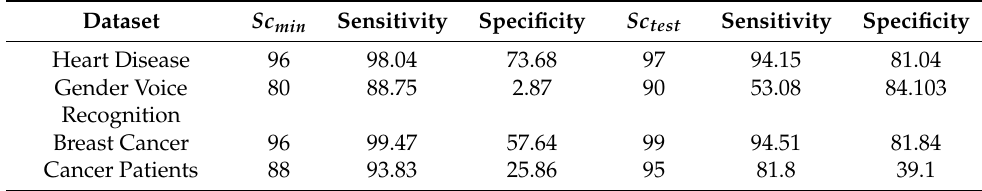
Table 8. S accuracy ( Sc test − min )